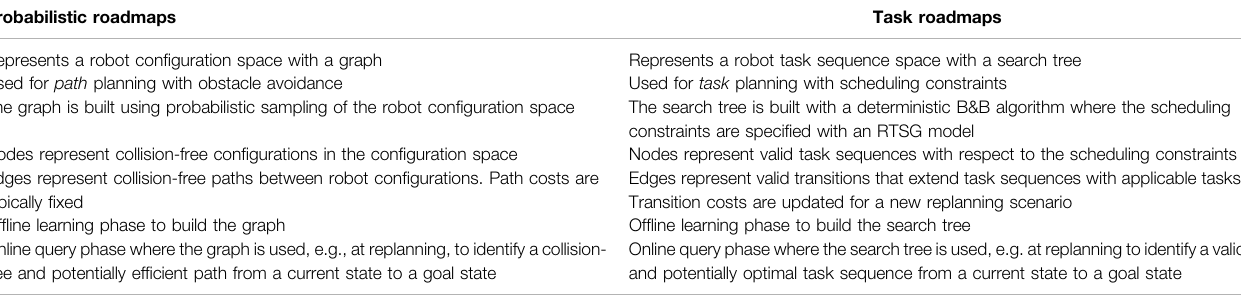
TABLE 1 | Similarities of the basic characteristics for Probabilistic Roadmaps and Task Roadmaps, respectively. Probabilistic roadmaps